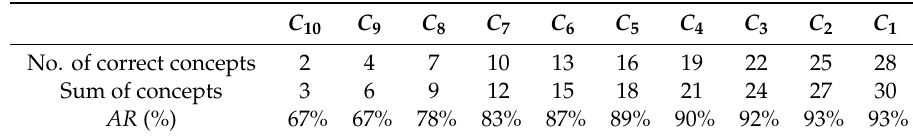
Table 11. Learning achievement results for student 4, who correctly answered Q 1 – Q 25 , Q 27 , Q 29 , and Q 30 .